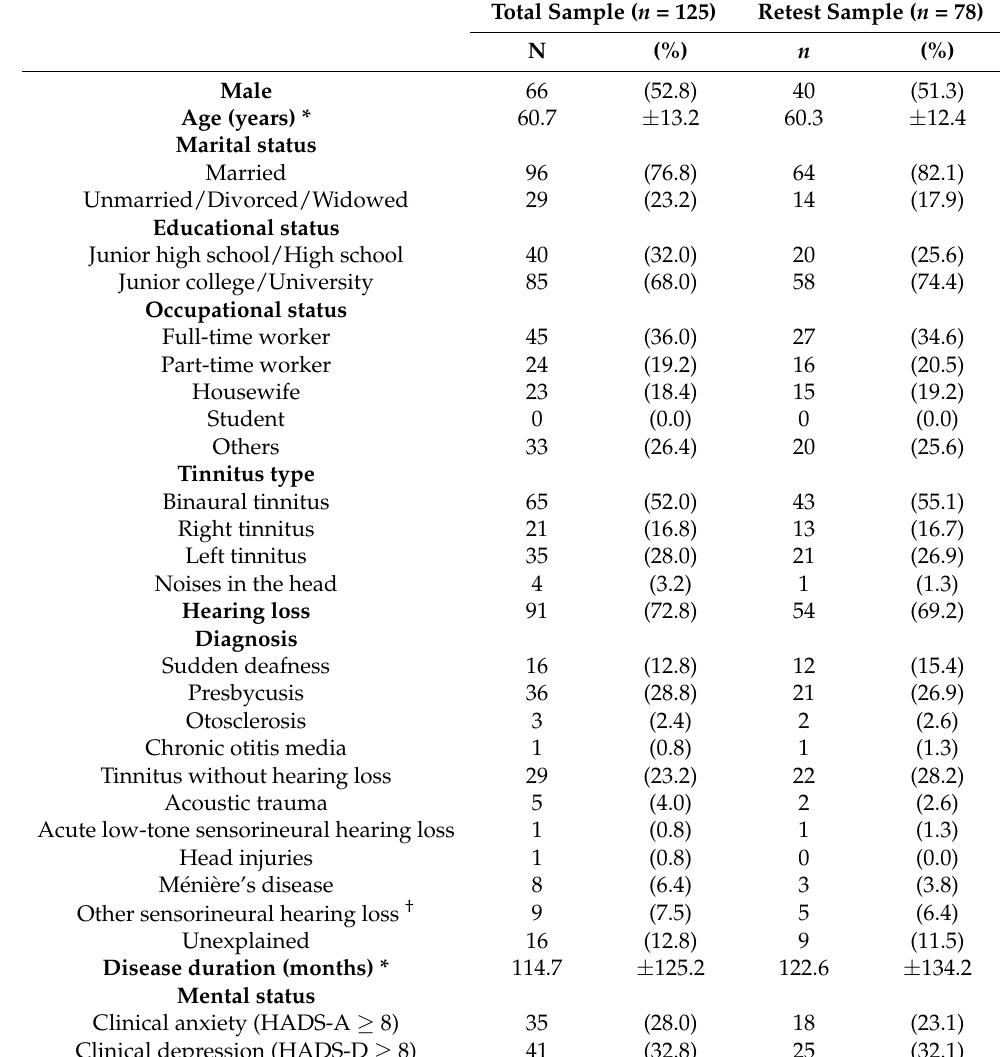
Table 2. Clinical condition and demographic features of the patients included in this